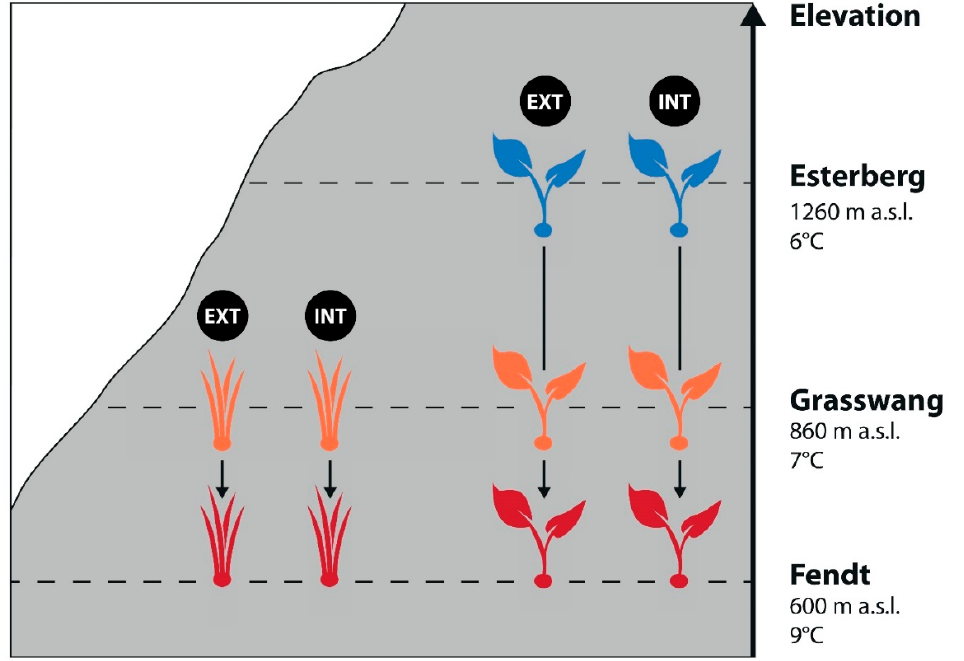
Figure 1. Scheme of experimental set-up. Each coloured plant symbol represents six plant-soil communities (replicates), translocated along an elevational and climatic gradient. The two different plant symbols represent communities from two different sites of origin, and colours represent climatic conditions, from cold (blue) to warm (red). The two contrasting—extensive (EXT) and intensive (INT)—land-use intensities are given on top of each respective row.